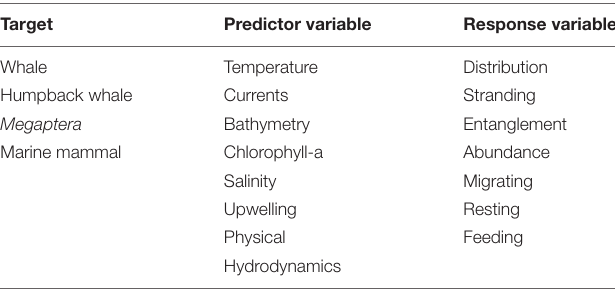
TABLE 1 | Combination of keywords used in online search for literature related to humpback whales and environmental variables.